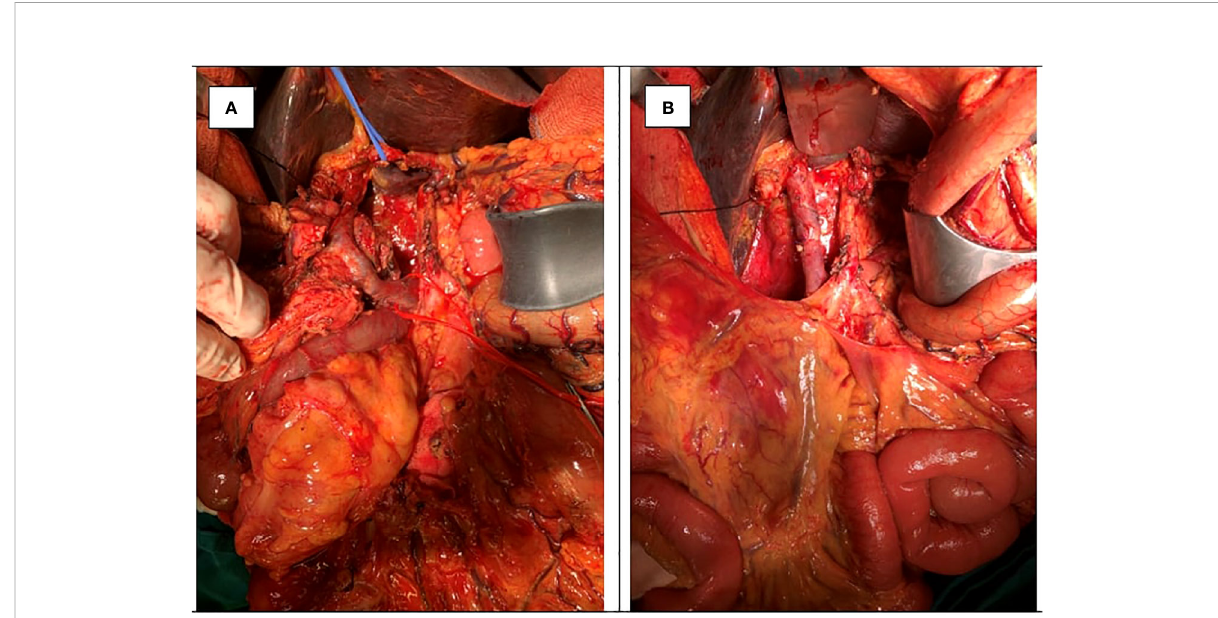
FIGURE 1 A 73-year-old man with pancreatic ductal adenocarcinoma (PDAC) with PV involvement (pT4N2M0 or Stage III according to AJCC Staging 2017) (A) underwent pancreaticoduodenectomy (PD) and total pancreatectomy with extended lymphadenectomy and segmental portal vein (PV) resection (B)